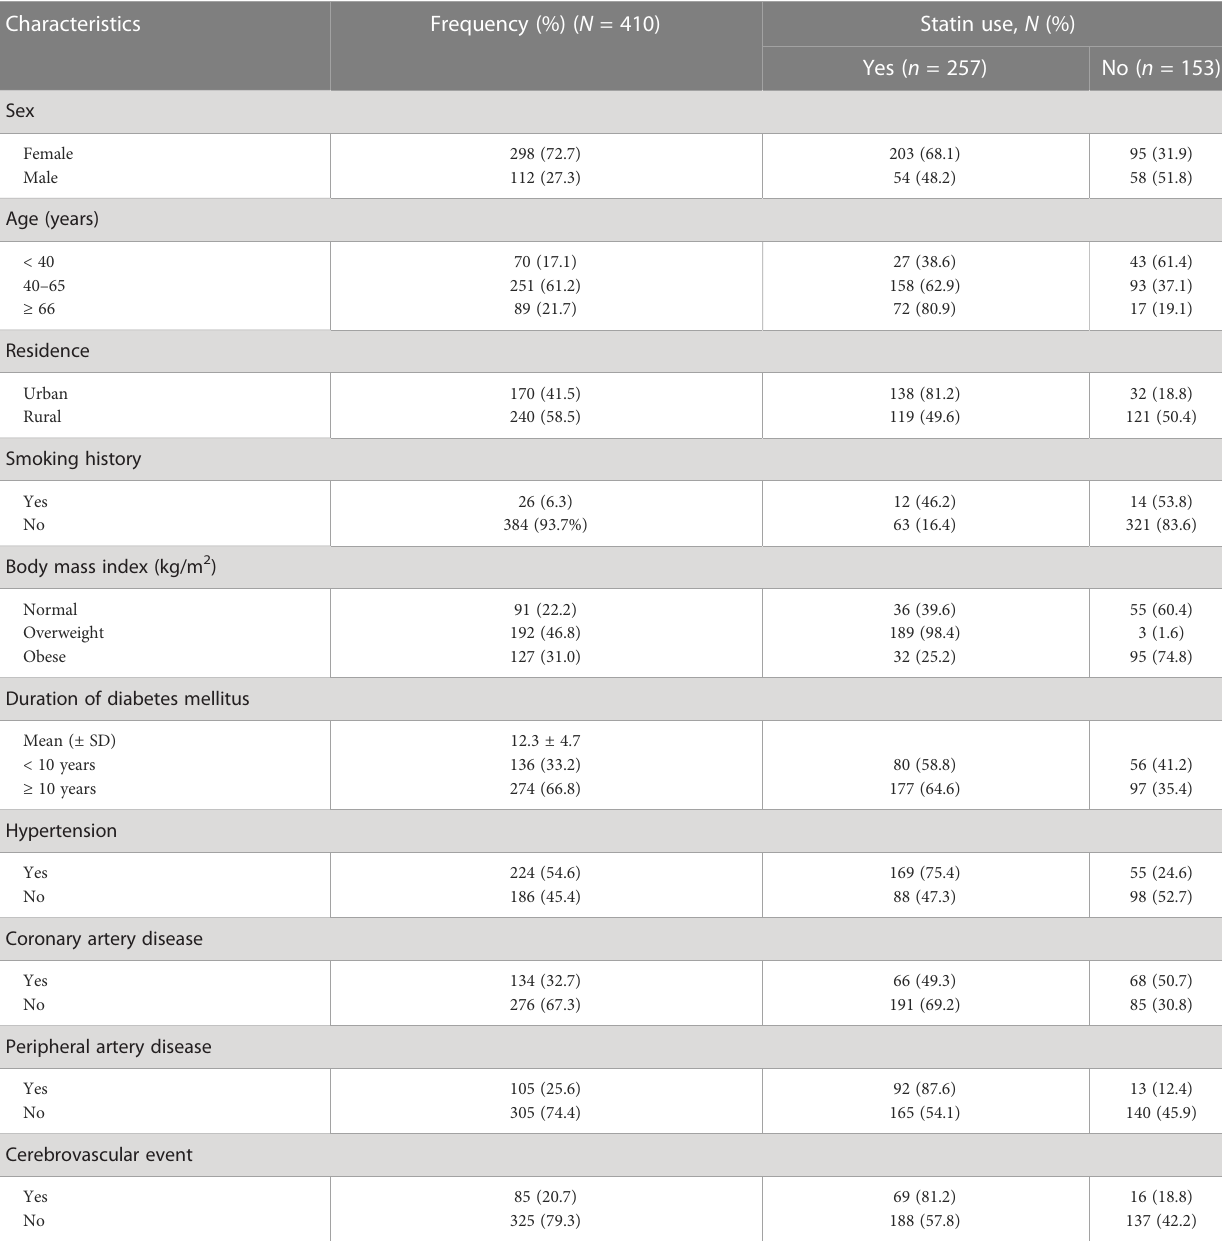
TABLE 1 Sociodemographic and clinical characteristics of type 2 diabetes mellitus (T2DM) patients in Jugol General Hospital in Harar in eastern Ethiopia: 2022.